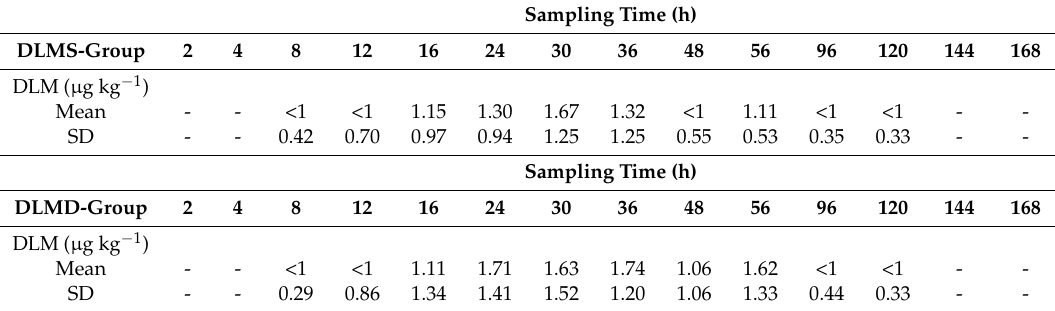
Table 4. Mean ± SD of DLM residue ( µ g kg − 1 ) in goat milk following pour-on DLM sheep dose (DLMS-group) and DLM sheep double dose (DLMD-group) treatment (groups of 7 animals each).